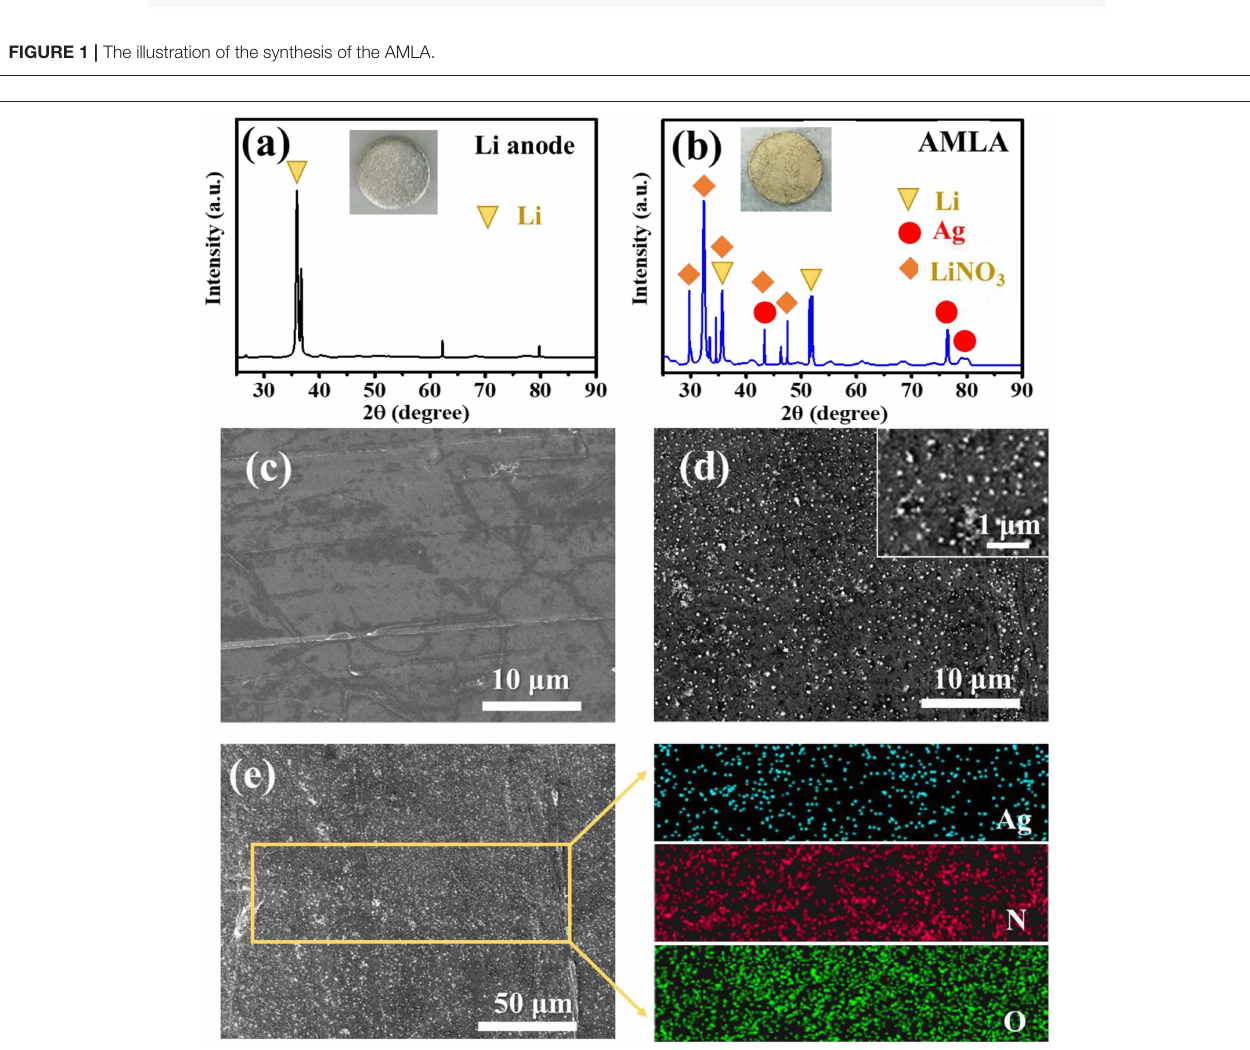
FIGURE 2 | The XRD curves of Li anode (a) and AMLA (b) , and the circle sheets in the figures represent the Li anode in different states. (c) The SEM image of Li anode. (d) The SEM image of AMLA. (e) The EDS images of ALMA, and the blue spots represent the element Ag, the red ones represent the element N, and the green ones represent the element